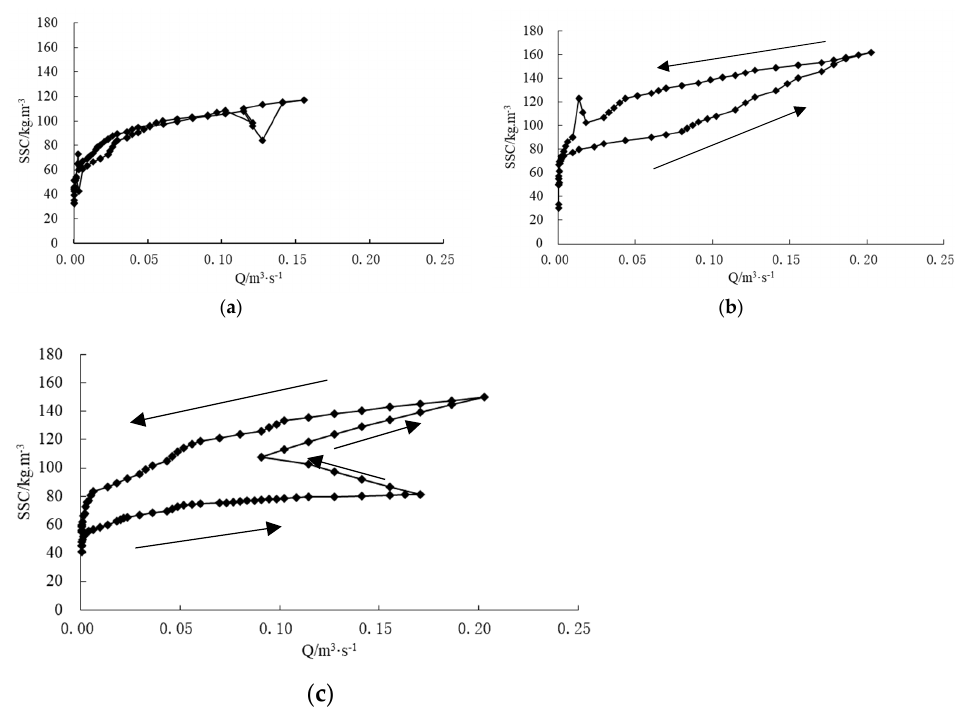
Figure 7. Relationships between SSC and Q of the geomorphic units on 19 July 2009. ( a ) Whole slope; ( b ) first branch of Qiaogou (subgully); ( c ) Qiaogou gully. ( b ) first branch of Qiaogou (subgully); ( c ) Qiaogou